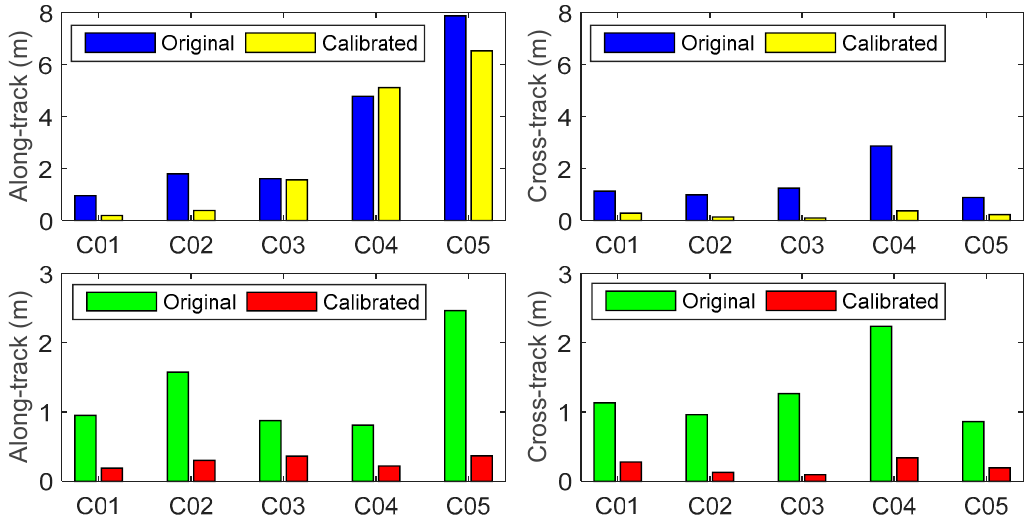
Figure 10. RMS of DBDs in along-track and cross-track for each BeiDou GEO satellite of the original fitted orbits and calibrated orbits with biases correction, top part of the figure denotes the RMS of all DBDs participate in statistics, the bottom part denotes the RMS by excluding the DBDs with more than 1 m in along-track or cross-track for the calibrated orbits.